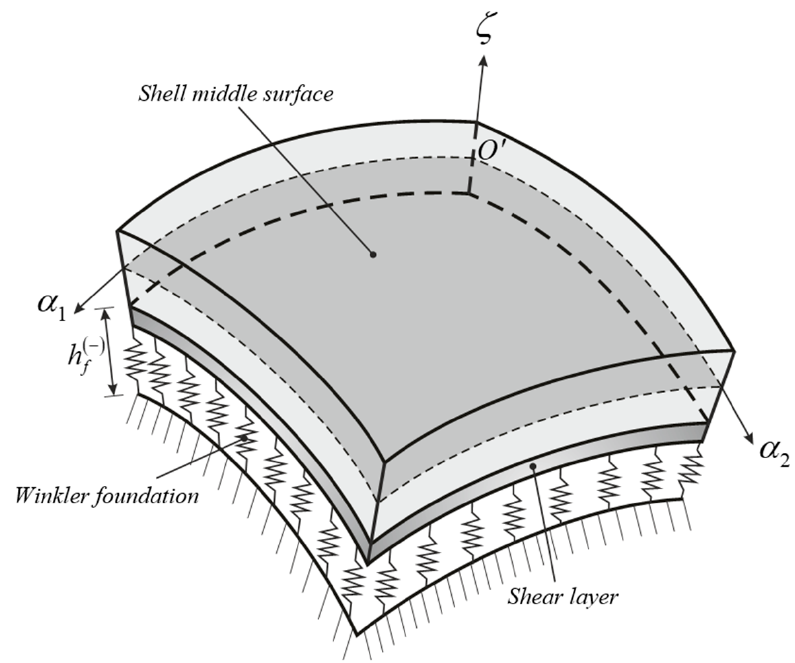
Figure 2. Doubly-curved panel representation and description.